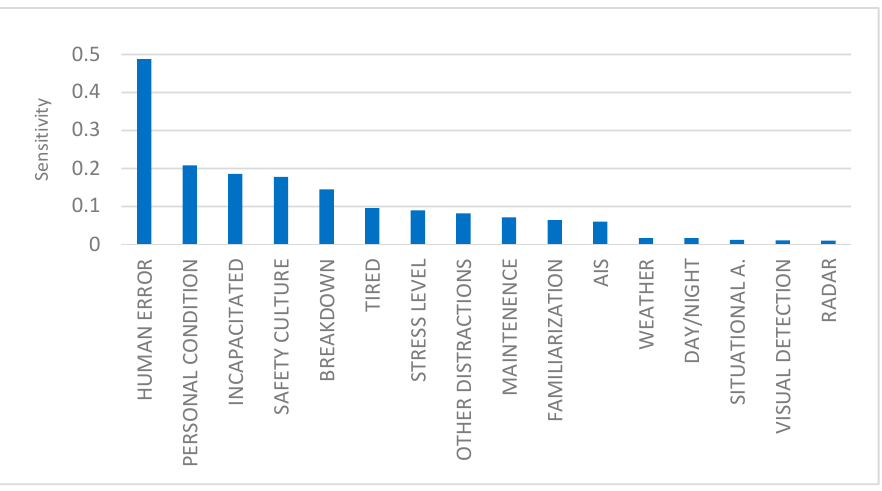
Figure 8. Sensitivity analysis for the grounding model when targeting “loss of control”.